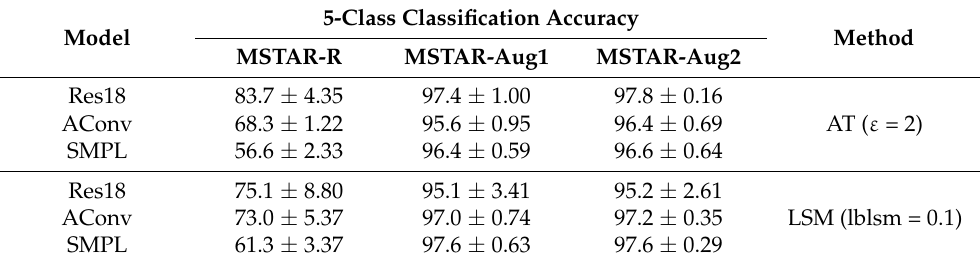
Table 3. Performance improvement of the neural networks provided by the synthetic images obtained via